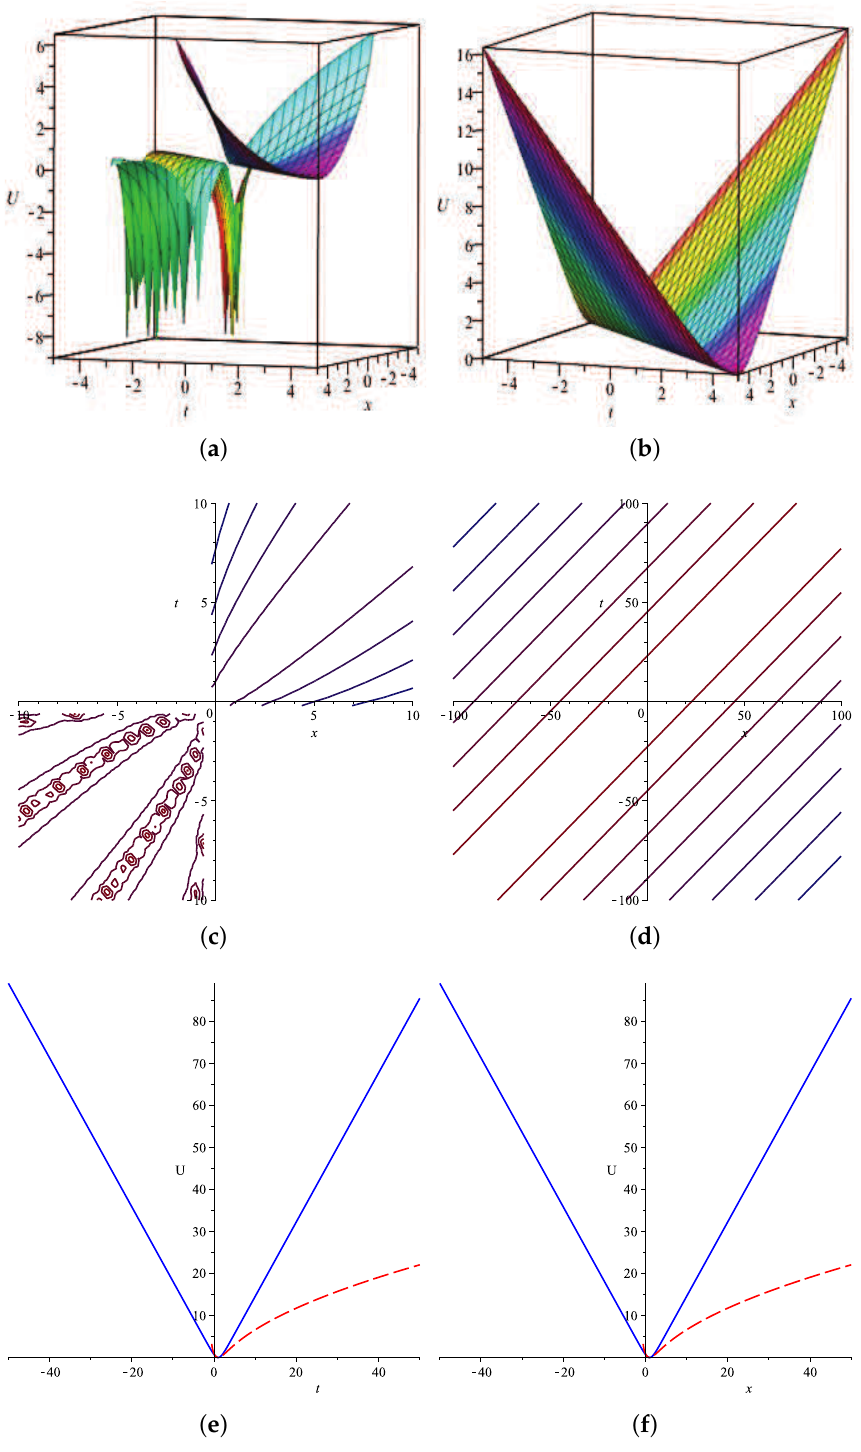
Figure 1. In ( a ), the graph of Equation (36) is given with β = 0.5, whereas, in ( b ), the graph of Equation (37) is given with β = 0.5 and α = 1. In ( c , d ), the 2D contours corresponding to the graphs ( a , b ) are given. ( e , f ) show 2D comparison of both solutions for x = 1 and t = 1,